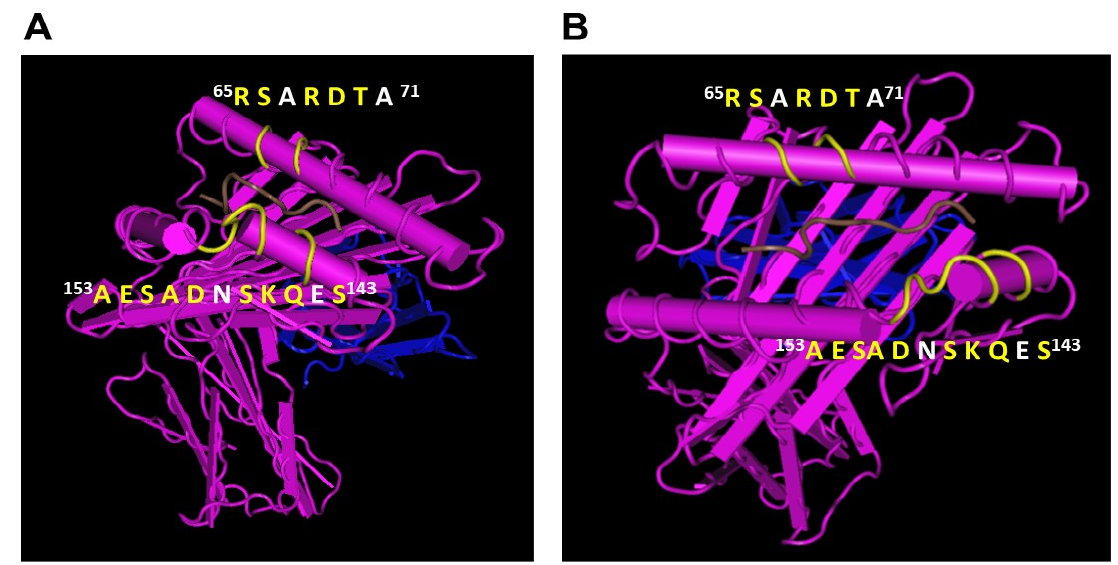
Figure 3. ( A , B ) represent the two different conformational orientations of HLA-E specific amino acid sequences exposed on α1 and α2 helices of HLA-E. Note a brown colored peptide sequence in the groove. The monospecific epitopes are on either side of the grove. These sequences are recognized by TFL-033 as evidenced by the binding inhibition of the mAb to the beadsets coated with HLA-E after incubation with the peptide sequences, synthesized and obtained commercially (GenScript Corporation, Piscataway, NJ, USA). It is important to note that the mAb recognizes the sequences, which are not linear but folded and exposing few amino acids (colored yellow) of the epitope for immune recognition; this is an important characteristics of HLA-E